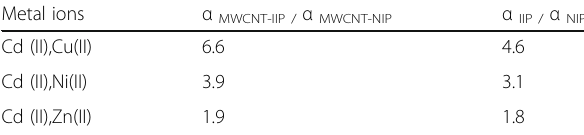
Table 4 selectivity factor various adsorbent verses Cd(II) ion Metal ions